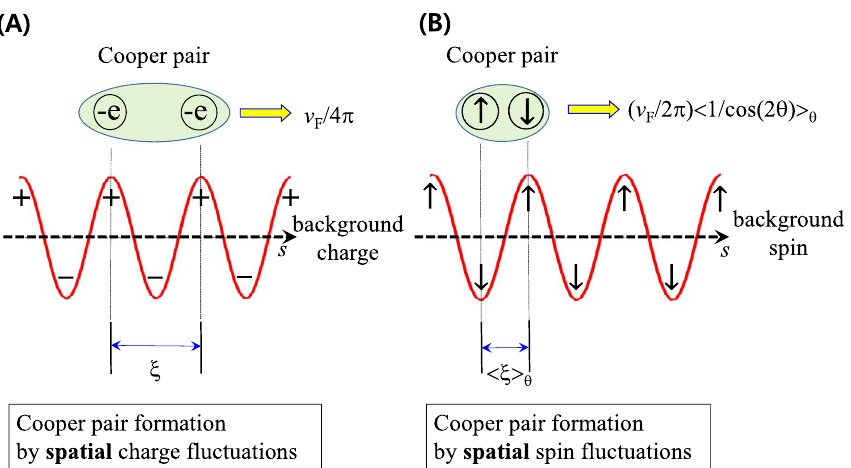
Figure 5. Spatial charge/spin fluctuations and Cooper pair formations. ( A ) Cooper pair formation by electric retarded interaction caused by the charge fluctuations in the conventional BCS superconductors. ( B ) Cooper pair formation by the retarded interaction caused by the spin fluctuations in the cuprate